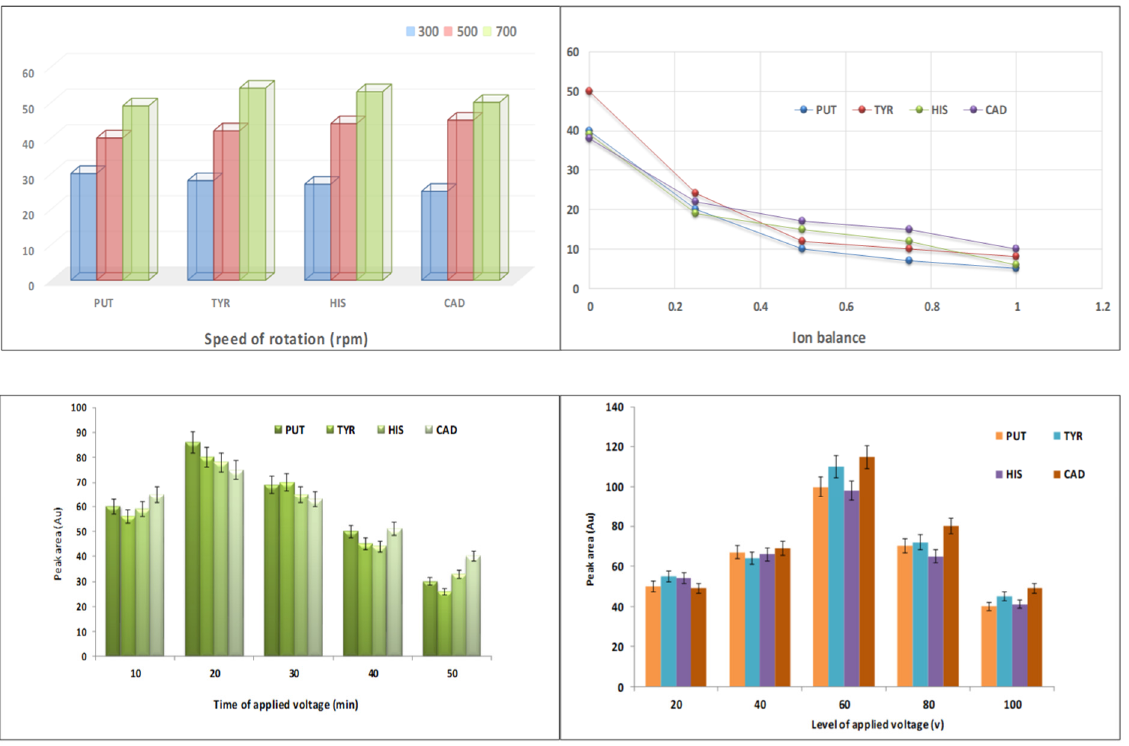
Figure 1. Optimization of speed of rotation, ion balance, time of applied voltage and level of applied voltage (HF-EME stage).